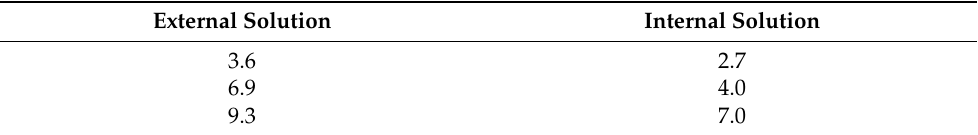
Table 5. pH of the external and internal CJMC-5 membrane solution according to the color indication scale (Figure